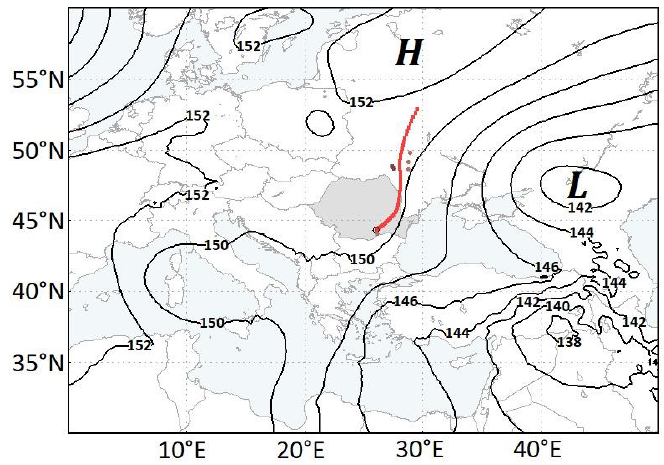
Figure 4. ERA5 reanalysis of mean geopotential height at 850 hPa (black contours) during 24 July 2016 00UTC and 25 July 2016 19UTC. The mean trajectory (red) is overlapped, and the fires are shown in brown dots (similar with Figure 2).